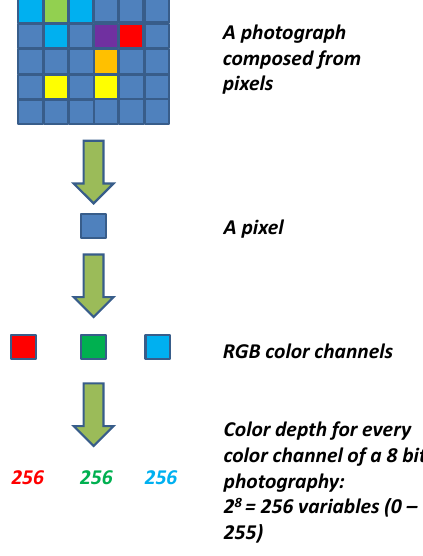
Figure 1 Explanation of digital information kept in an 8 bit photograph.